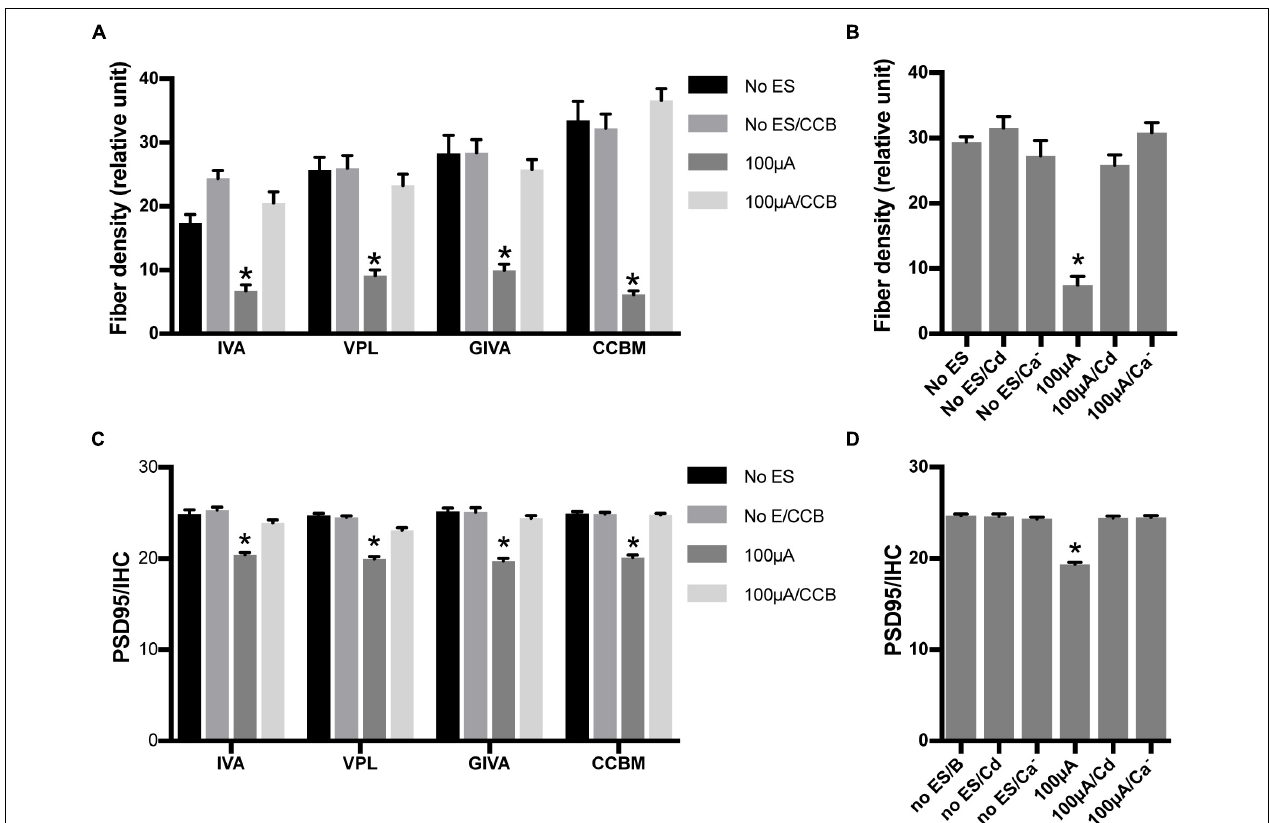
FIGURE 5 | Inhibiting calcium influx attenuated the loss of SGN peripheral fibers and IHC synapses induced by ES. (A) PSD95/IHC ratio was significantly decreased in explants treated with 100 µ A/48 h ES compared with non-ES explants, while explants simultaneously treated with 100 µ A/48 h ES and various types of voltage-dependent calcium channel blockers (CCB), including 10 µ M VPL, 1 µ M GVIA, 1 µ M IVA and their mixture (CCBM), were not significantly different from the non-ES group n = 7–12 in each group. (B) When ES-treated explants were also treated with 10 µ M Cd or maintained in calcium-free medium (Ca - ), the PSD95/IHC